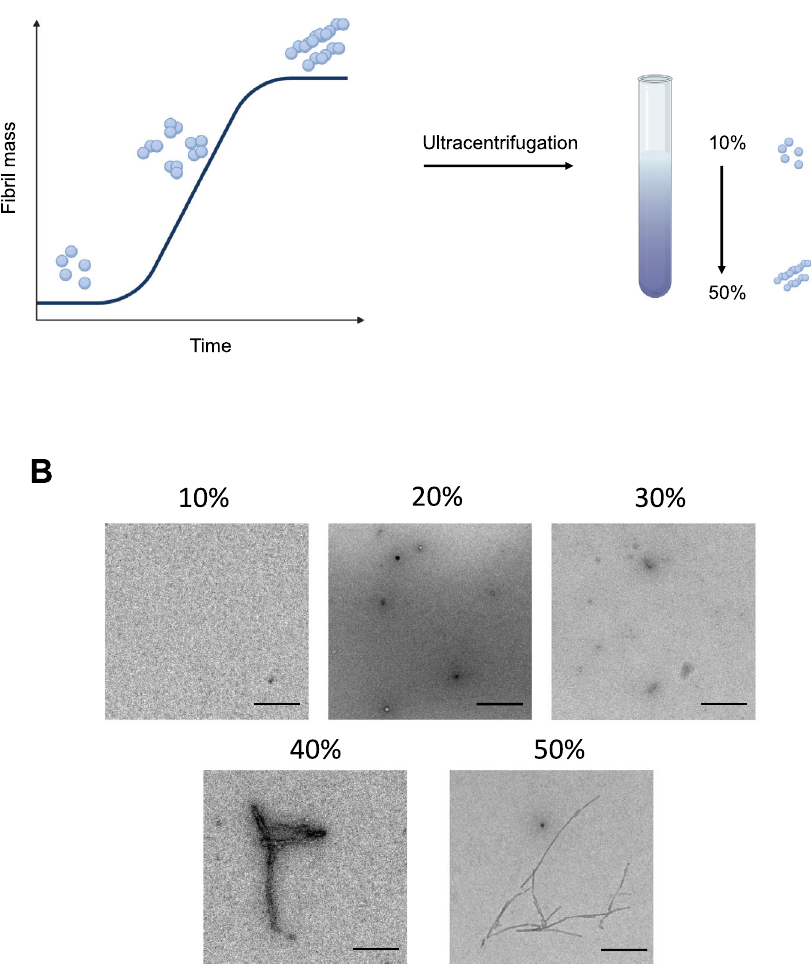
Fig. 1 | Principle of protein separation by sucrose density centrifugation. A Schematicrepresentationofsucrosedensitycentrifugationforaproteinmixture. Invitro α -synucleinisaggregatedandatspeci fi ctimepointsaliquotsaretakenfrom the aggregation reaction. All time points are combined in a sucrose solution with increasing sucrose concentration (10, 20, 30, 40, and 50%, from top to bottom).